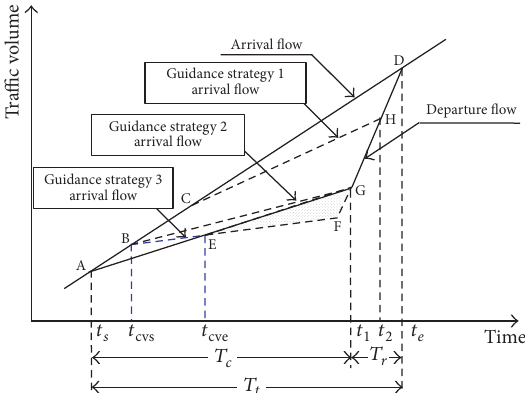
Figure 1: Impact of CV guidance strategy on traffic flow. 𝑡 𝑠 —start time of traffic congestion; 𝑡 cvs —start time of CV guidance strategy 3 ; 𝑡 cve —end time of CV guidance strategy guidance strategy 2 ; 𝑡 2 —end time of guidance strategy 1 ; 𝑡 𝑒 —end time of